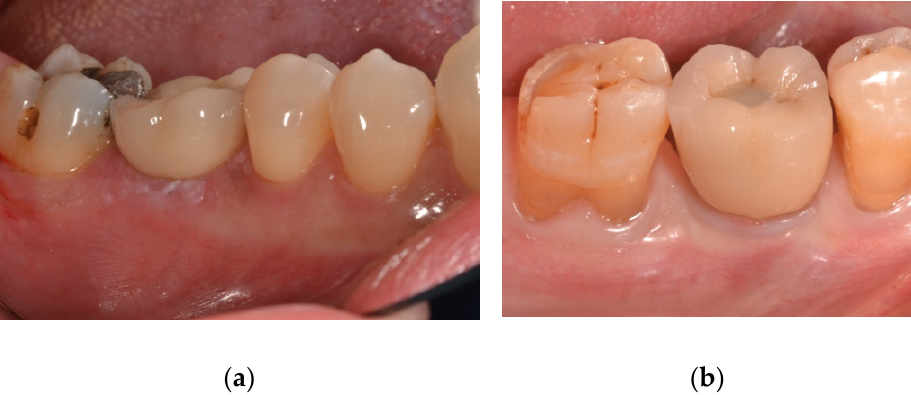
Figure 4. Photos when the screw restoration was delivered. ( a ) Nobel Parallel; ( b ) Prama Sweden & Martina.